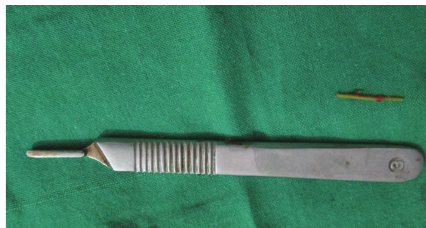
Figure 5: Image shows a foreign body that corresponded to a plant